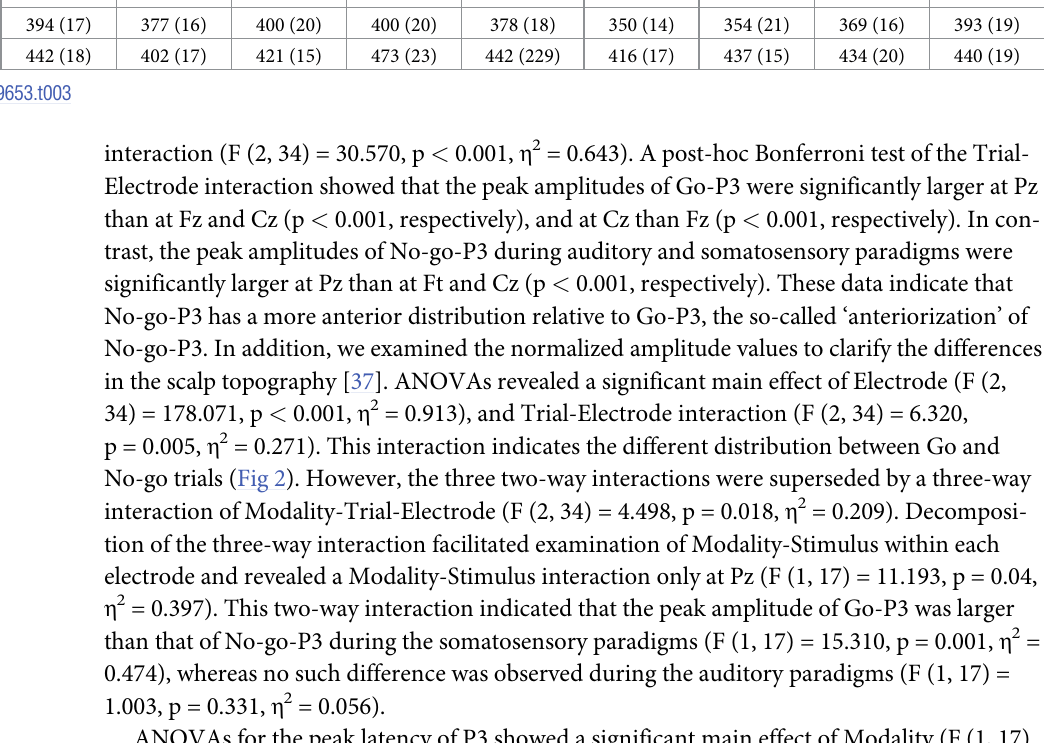
Table 3. Average values for N2 and P3 in Go and No-go stimulus during somatosensory and auditory Go/No-go paradigms with SE.